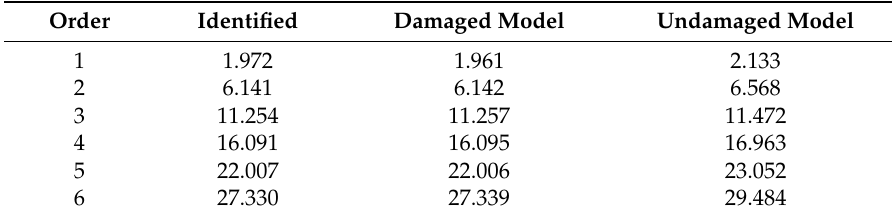
Figure 5. The first six mode shapes of the theoretical undamaged model. Table 1. The first six frequencies of structure in different cases (Hz).